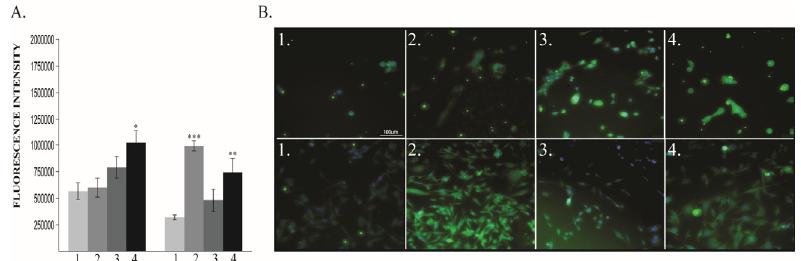
Figure 7. HIF-1 α protein expression. ( A ) Protein quantification: left MCF10A, right MDA-MB-231; ( B ) Immunofluorescence pictures: upper panel MCF10A, lower panel MDA-MB-231; 1 — 21% O 2 , 2 —